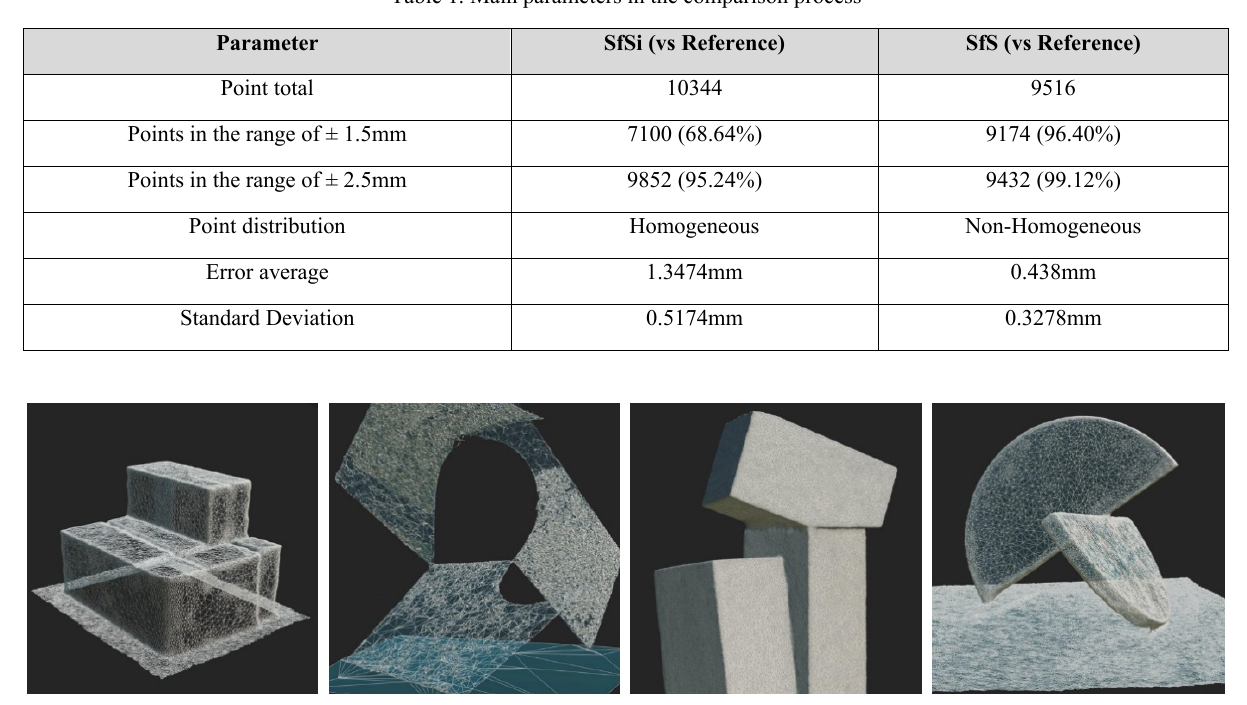
Table 1. Main parameters in the comparison process